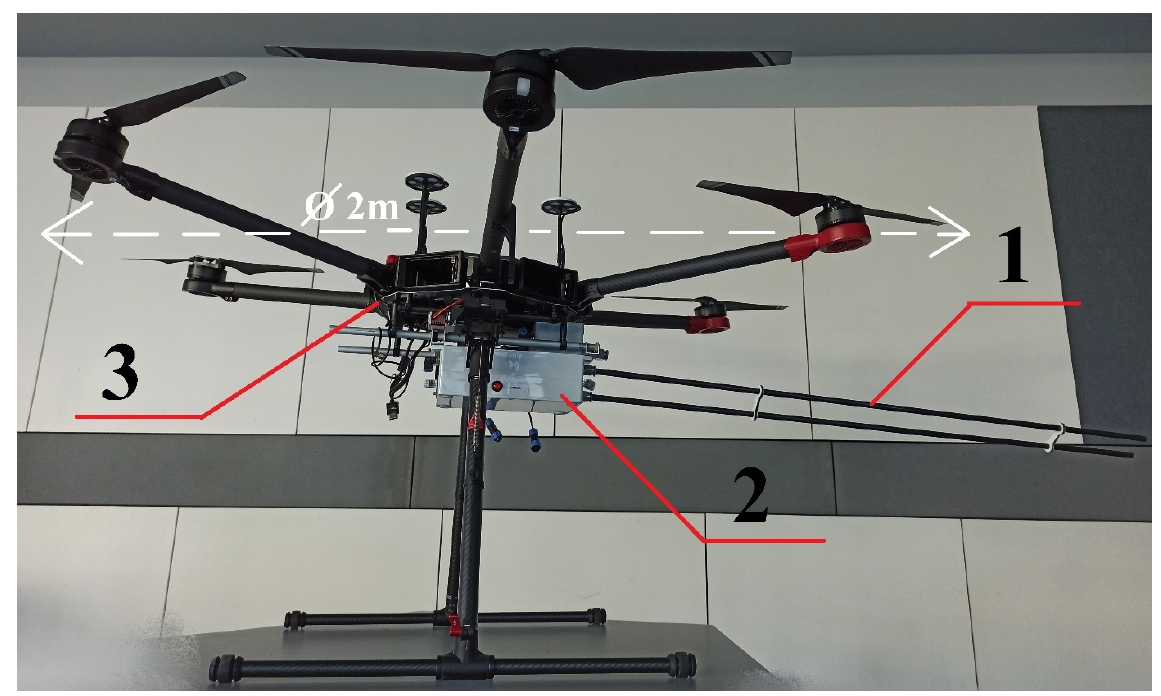
Figure 3. Unmanned aerial vehicle (UAV) with measuring equipment: 1—measuring probe; 2—measuring equipment, 3—UAV.